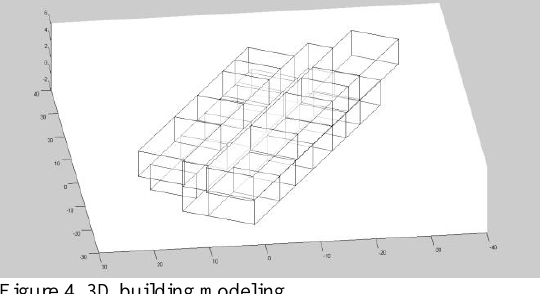
Figure 4. 3D building modeling. Connection between control